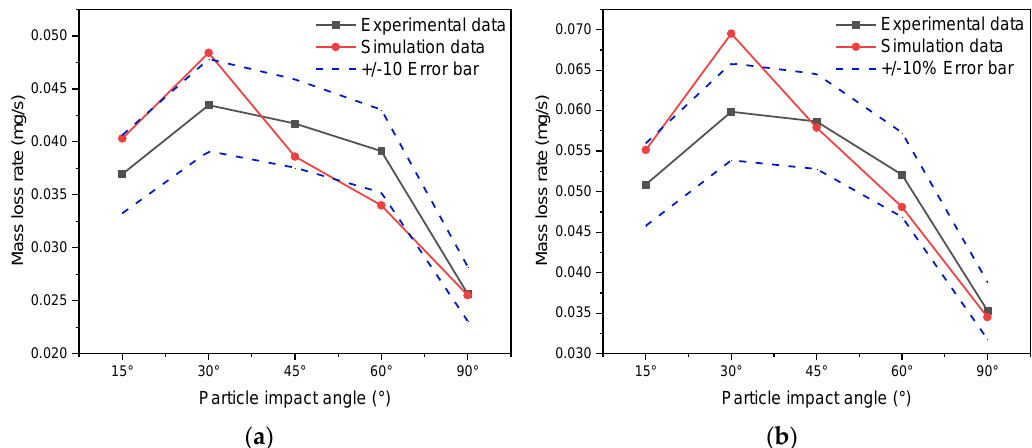
Figure 3. The relationship between erosion rate and particle impact angle. ( a ) Gas velocity 26.2 m/s and particle mass flow rate 10.73 g/s; ( b ) Gas velocity 28.82 m/s and particle mass flow rate 11.37 g/s.